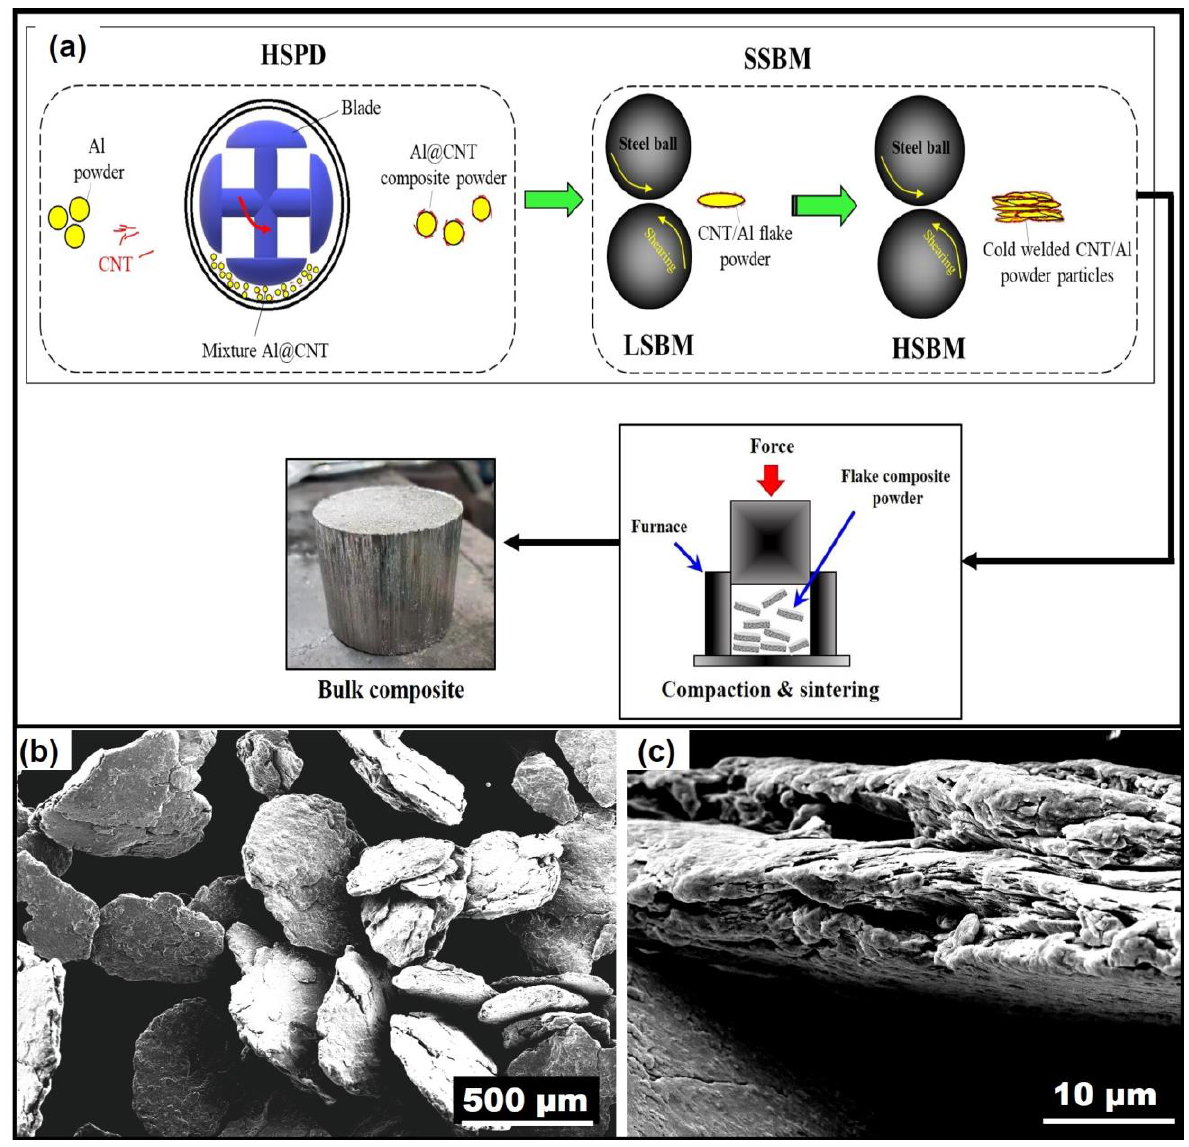
Figure 6. ( a ) The schematic of fabrication CNT/Al composite via FPM-HSPD/SSBM technique: High-shear pre-dispersion process coats CNTs uniformly onto spherical Al powders, shift-speed ball milling process redistributes CNTs into Al flakes [42], ( b , c ) CNT/Al laminated particle, and a side cross-section view of particle after FPM-HSPD/SSBM route.